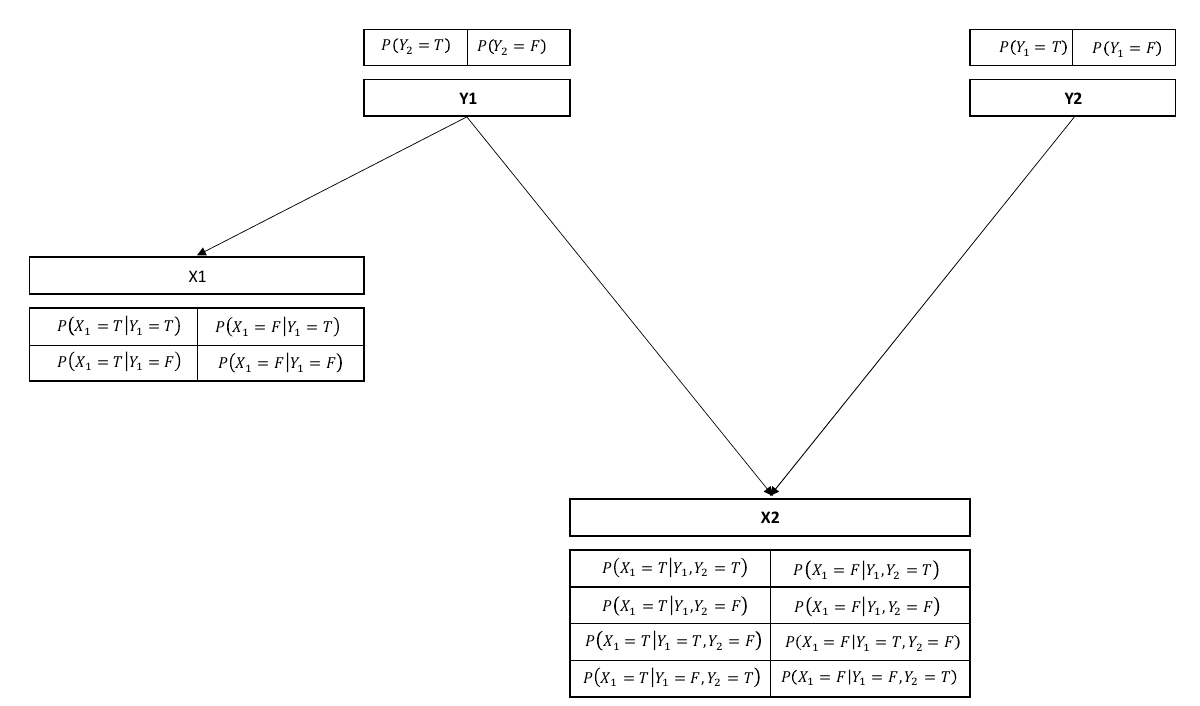
Figure 2. A Bayesian network with four variables and local conditional probability